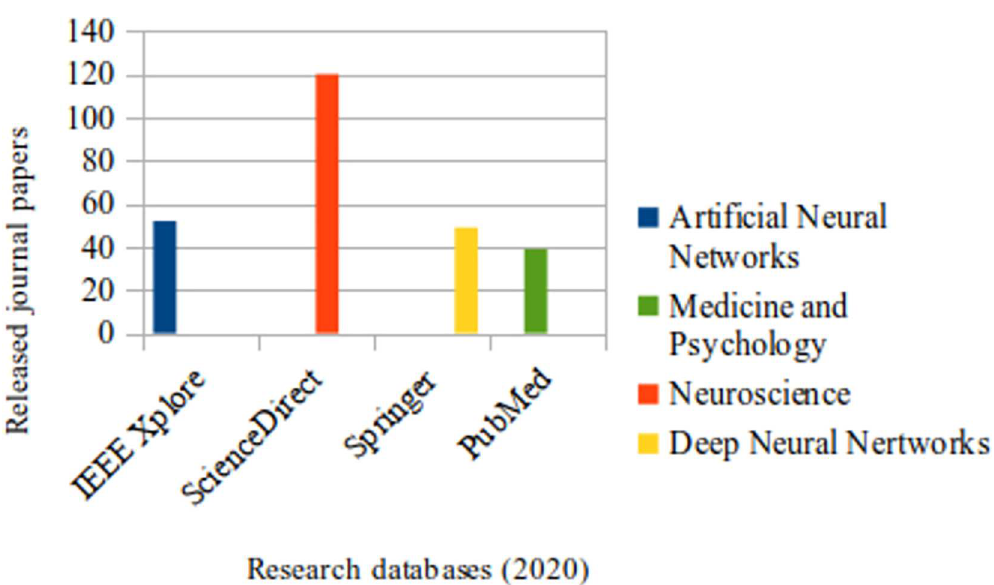
Fig 3. Released papers for each database corresponding to each related subject.